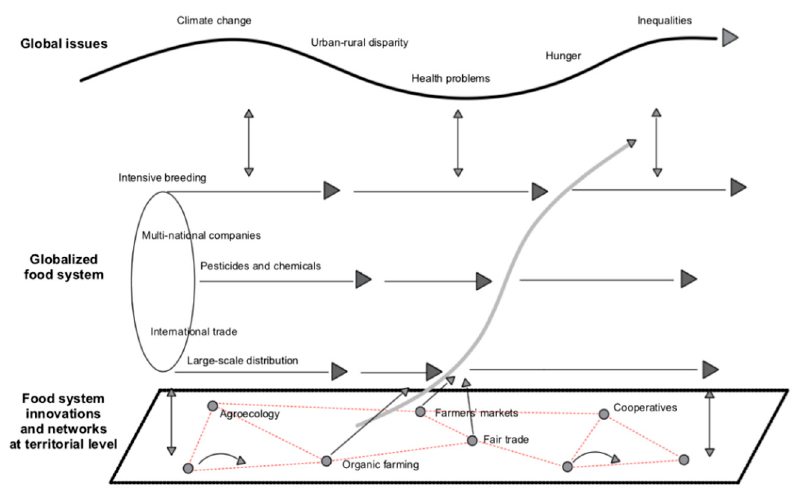
Figure 1. The Multi-Level Perspective model adapted to the sustainable food system transition and provided by the territory and networks (authors’ elaborations).